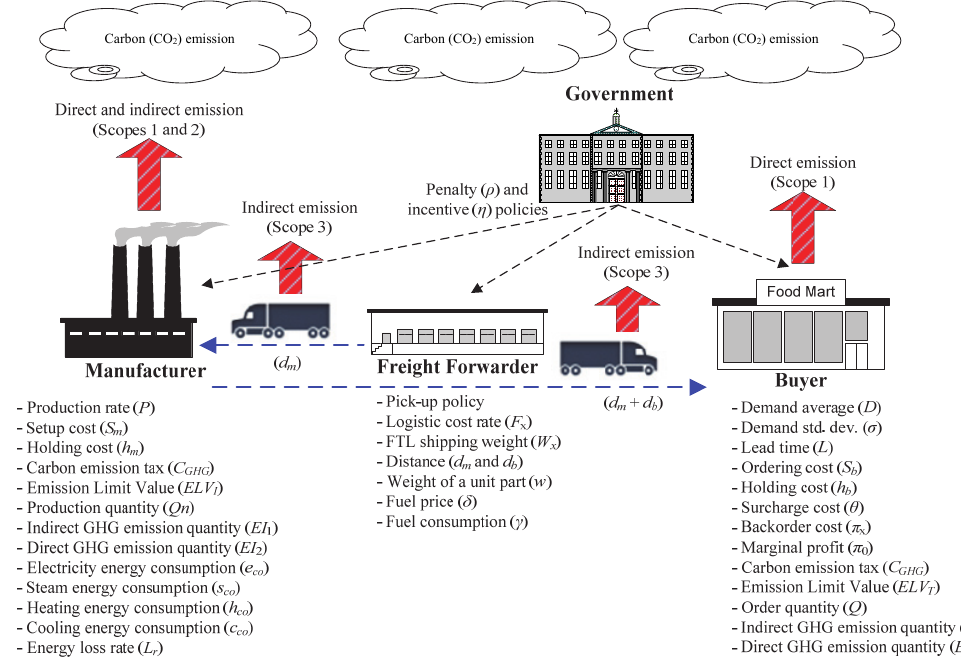
Fig. 2. The overview of problem in this